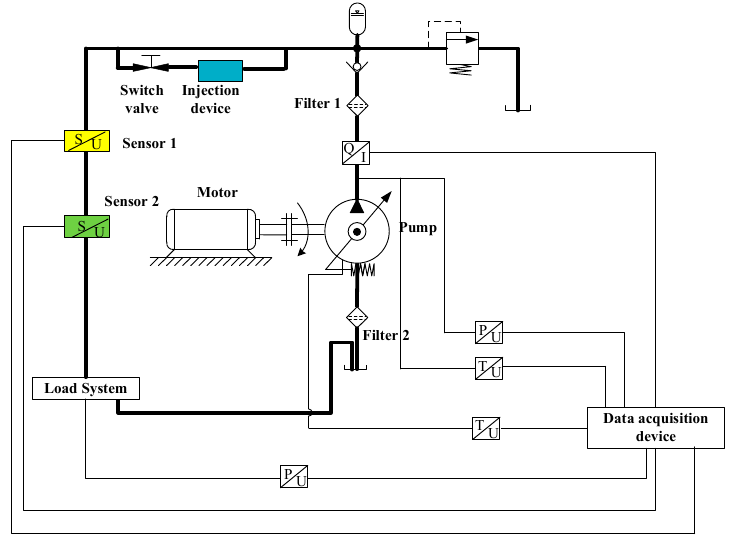
Figure 4. Experiment layout.